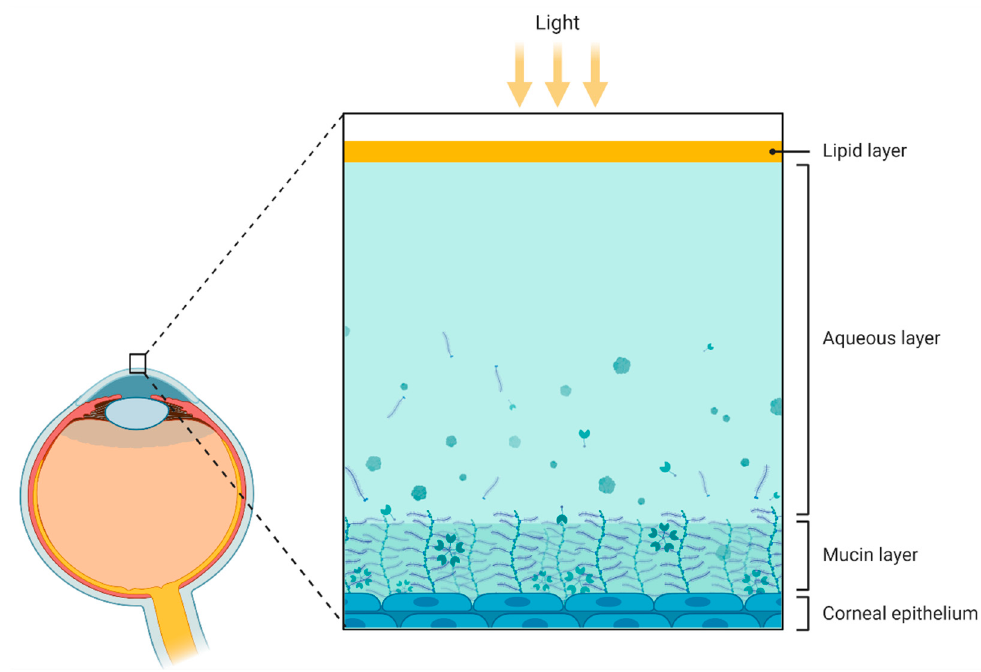
Figure 3. Schematic representation of the compartments presented in the tear fluid. From outer to inner: lipid layer, aqueous layer, mucin layer (containing glycoproteins called mucins), and corneal epithelium. Figure created by BioRender.com software (Toronto, ON, Canada).